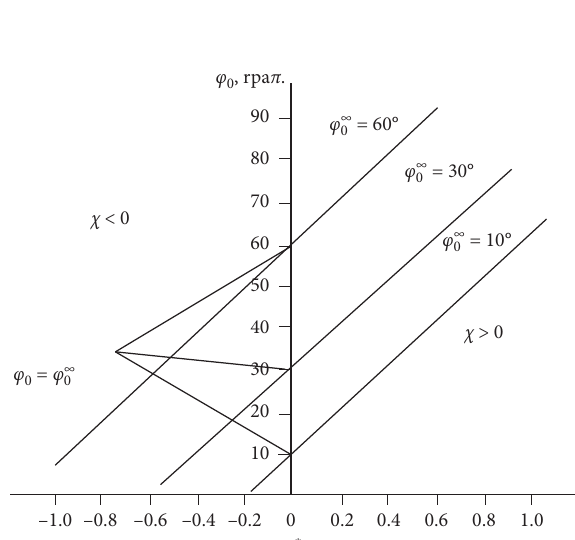
Figure 4: SEM image of needle NWs: (a) Si and (b) GaAs.